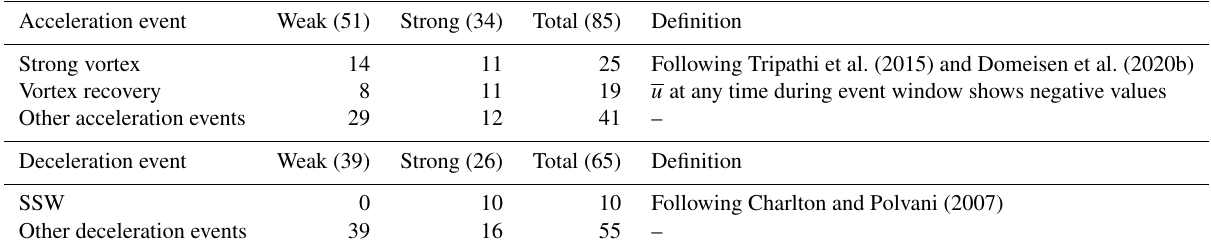
Table 1. Identified acceleration and deceleration events from reanalysis. The numbers in the brackets specify the number of events in each